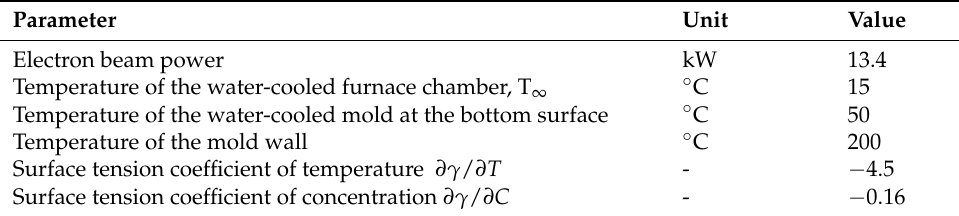
Table 3. Summary of main parameters in EEBM experiments